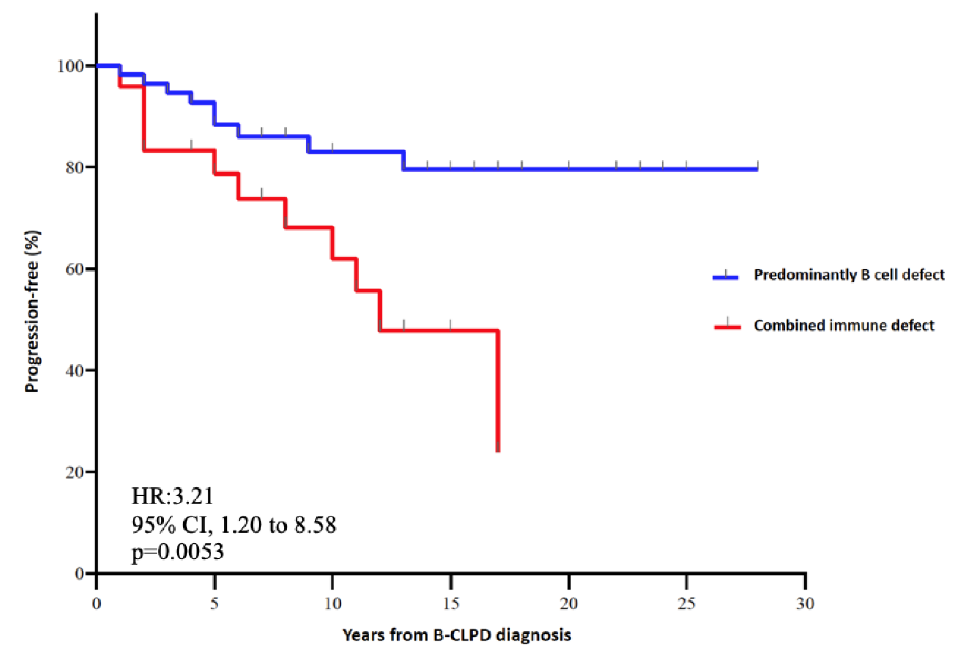
Figure 2. Kaplan–Meier plot of progression-free and hazard ratio according to the immune defect phenotype.